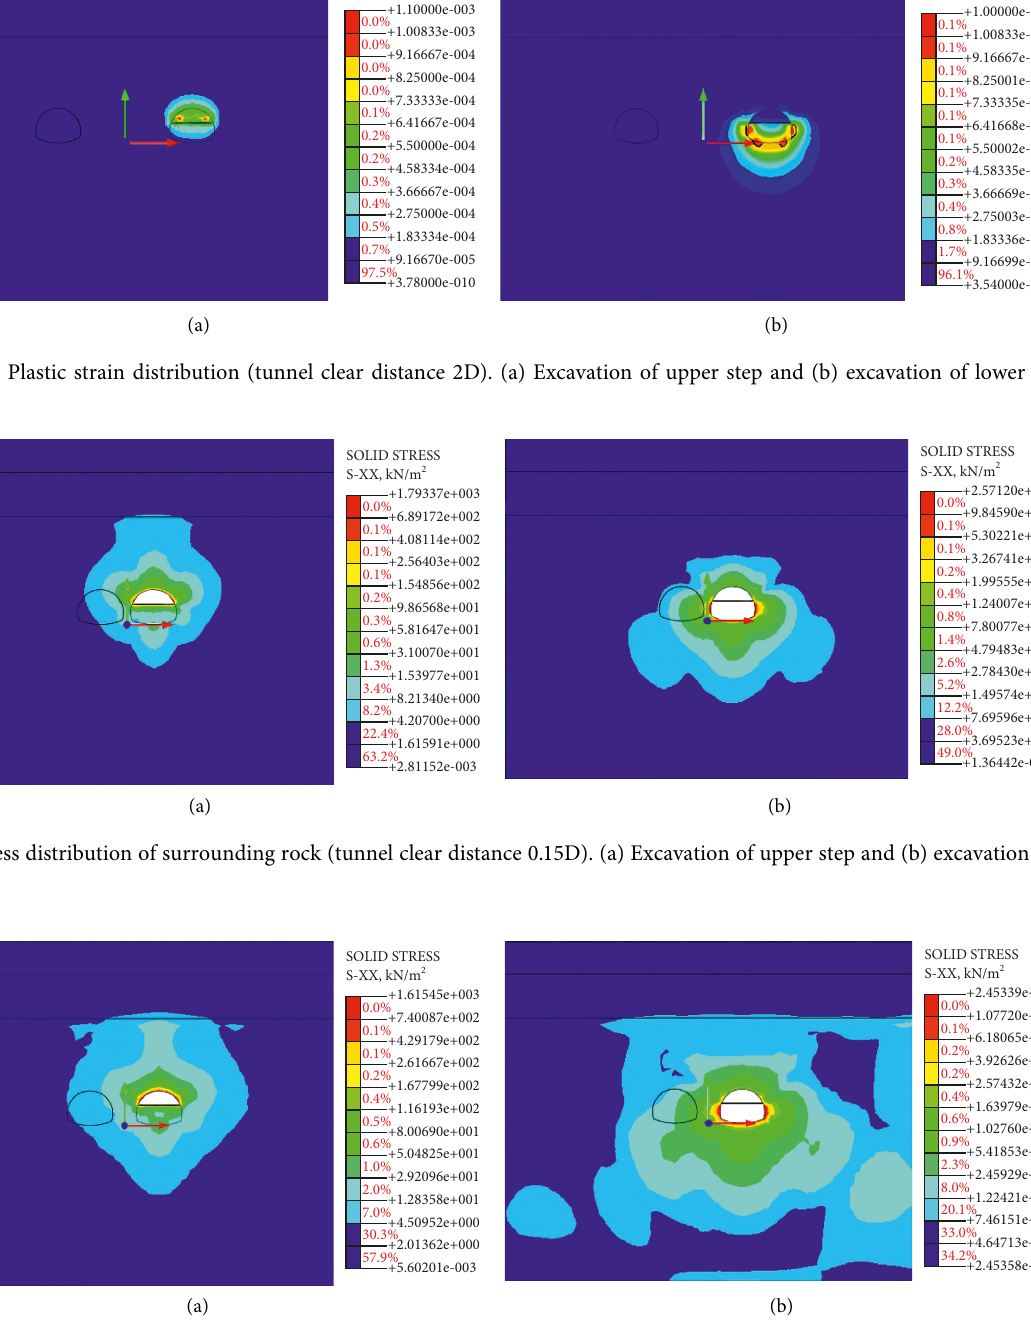
Figure 22: Stress distribution of surrounding rock (tunnel clear distance 0.5D). (a) Excavation of upper step and (b) excavation of lower step.